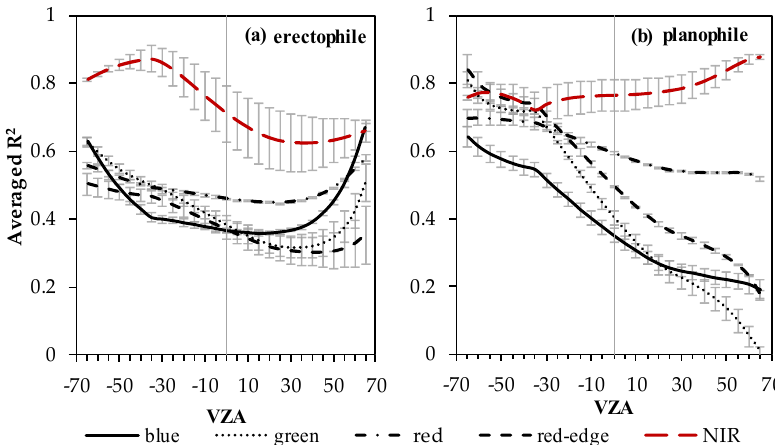
Figure 3. Coefficients of determination (R 2 ) of the linear relationships between LAI and red, blue, green, red-edge, and NIR bands at different VZAs in principal plane (PP) for ( a ) planophile and ( b ) erectophile varieties based on the measured datasets. The y-axis indicates the average R 2 of the linear relationships between LAI and R x at each view angle (R x : Reflectance at wavelength of x presented in Section 2.3.2: 1. Raw reflectance). Standard deviation bars are indicated.